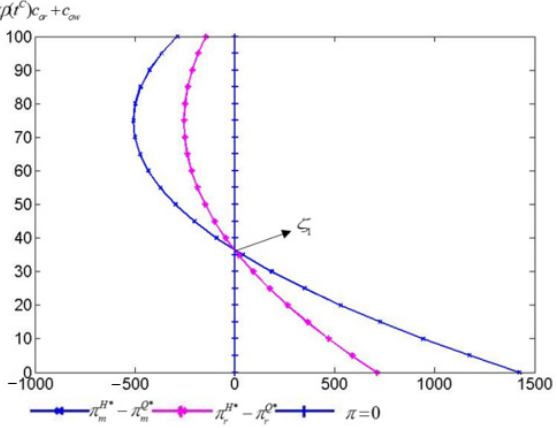
Figure 7. Investment conditions of chain members in the H situation.